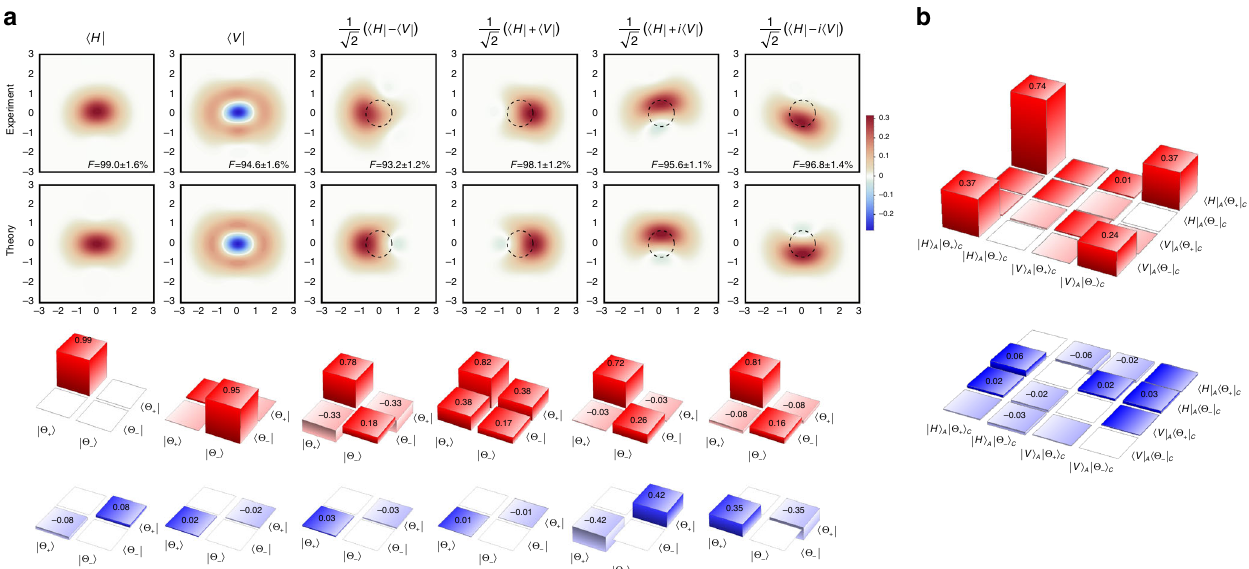
Fig. 2 Results of the remote state preparation experiment. a The state of the CV mode C when the DV mode A is projected onto various polarization states. Top rows: experimental and corresponding theoretical Wigner functions. Red color indicates positive values, blue — negative. Theoretical Wigner functions correspond to superpositions Eq. (5) of cat states. The dashed circles correspond to the half-height of the vacuum state Wigner function. Superpositions of cat states that correspond to the projections onto diagonal polarizations approximate coherent states, hence their Wigner functions exhibit displacement relative to the origin of a phase space. The fi delities between the experimentally acquired states and theoretically expected superpositions of cat states are shown. Bottom rows: projections of the experimental density matrices onto the subspace spanned by Θ imaginary in blue. Note that these density matrices are not normalized because of the imperfect overlap of the reconstructed states with this subspace. b Density matrix of the reconstructed DV-CV state in modes A and